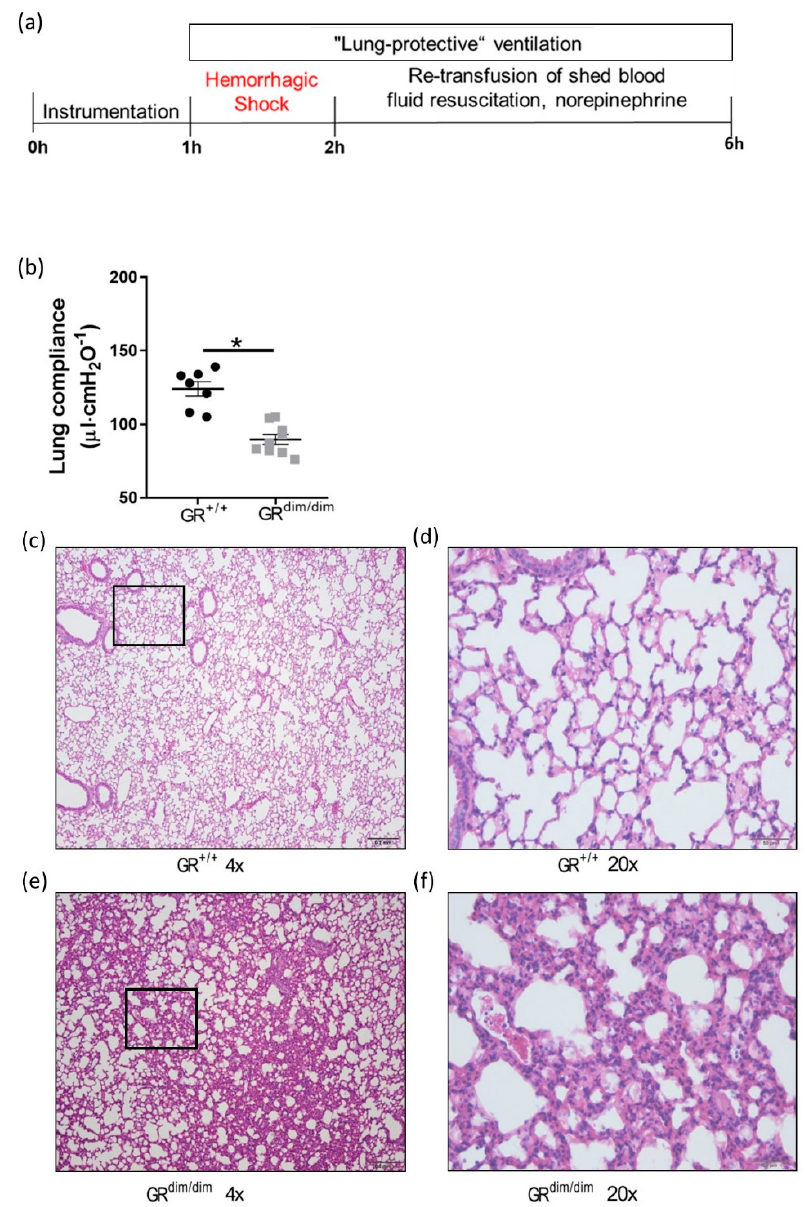
Figure 1. GR dim/dim mice show pulmonary impairment after resuscitation from HS. ( a ) After instrumentation, all animals underwent HS followed by 4 h of resuscitation in MICU. After in total 6 h, the mice were euthanized for sample collection. ( b ) After HS, GR dim/dim showed a reduced lung compliance at the end of the experiment as marker for impaired lung mechanics compared to GR +/+ after HS. ( c ) Exemplary hematoxylin and eosin (HE) stained lung section (4× magnification) from GR +/+ mouse with indicated area of ( d ) 20× magnification. ( e ) HE stained lung section of GR dim/dim mouse (4× magnification) with indicated area of ( f ) 20× magnification. Quantifications are shown as mean with standard error of the mean (SEM). Significance was analyzed with unpaired Mann-Whitney and indicated according to * p < 0.05.